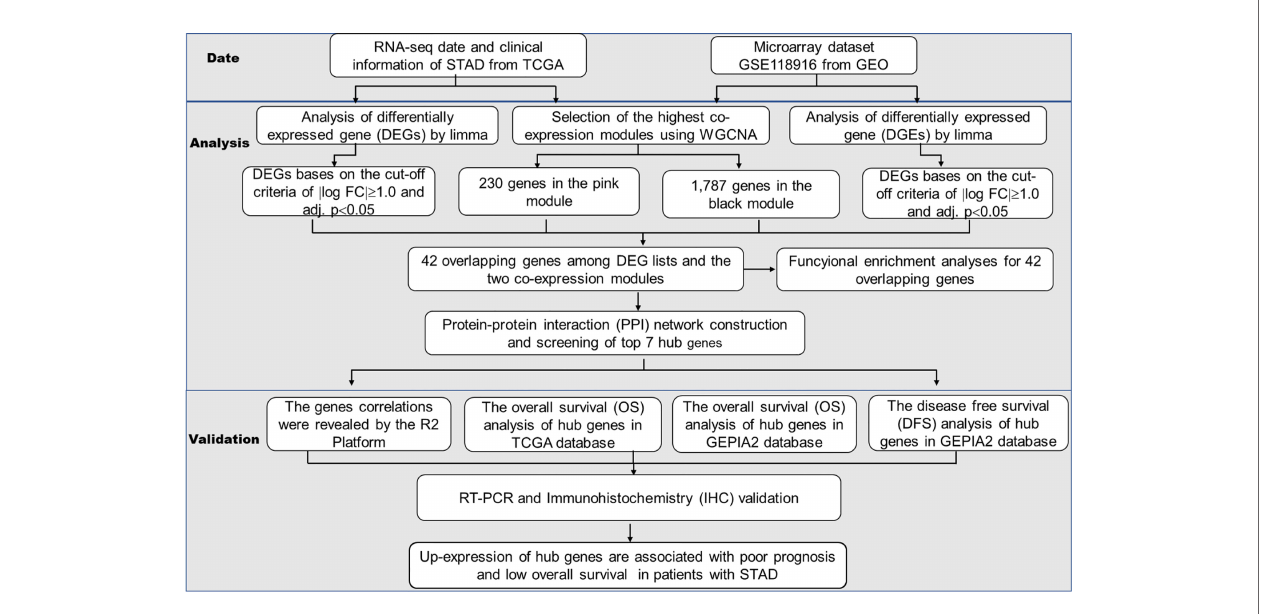
FIGURE 1 | The work fl ow of the analysis of the hub gene extraction curation